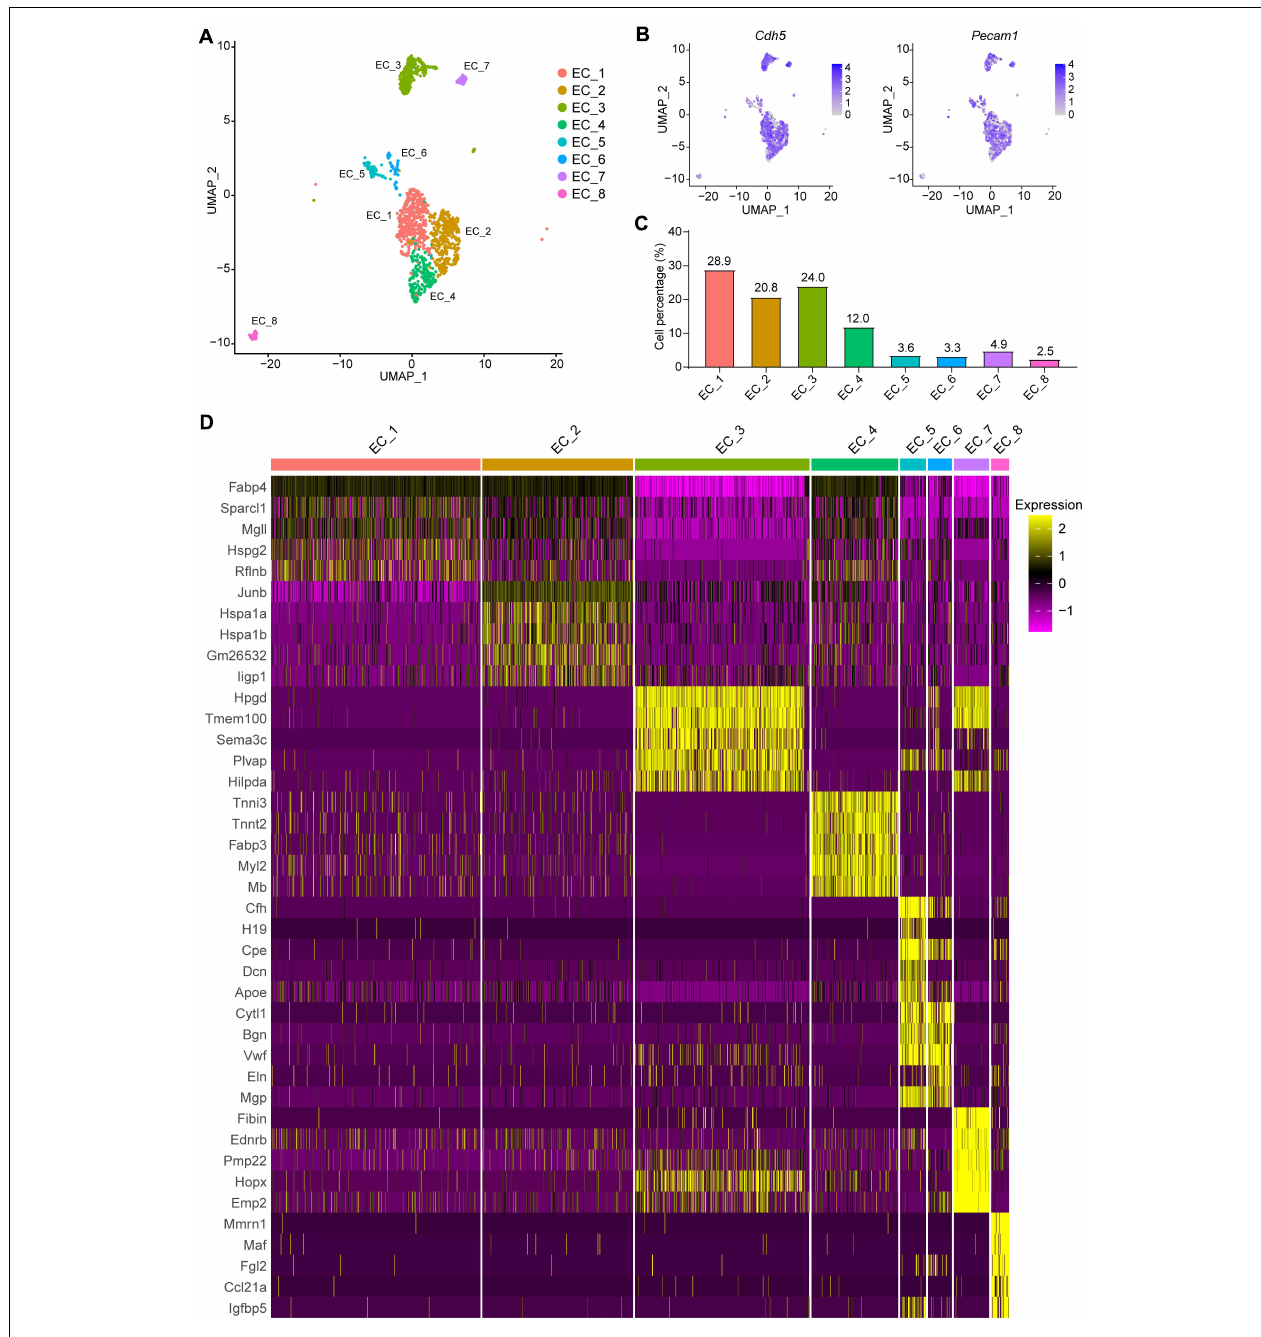
FIGURE 2 | Categorization of endothelial cell subpopulations. (A) , UMAP plot of the aggregate ECs with positive expression of Cdh5 , Pecam1 , Tek, or Vwf . Eight EC clusters were identified in the aggregate arterial ECs. (B) , Feature plot of EC marker genes Cdh5 and Pecam1 in the EC clusters. (C) , Percentage of cells in each EC cluster. (D) , The top5 markers for each cluster were selected based on the average Log2(fold change). The FindAllmarkers function in Seurat v4.0 was performed using non-parametric Wilcoxon rank sum test with parameters min.pct = 0.25, thresh.use = 0.25, only.positive = TRUE and return.thresh = 0.01, to find all markers for each